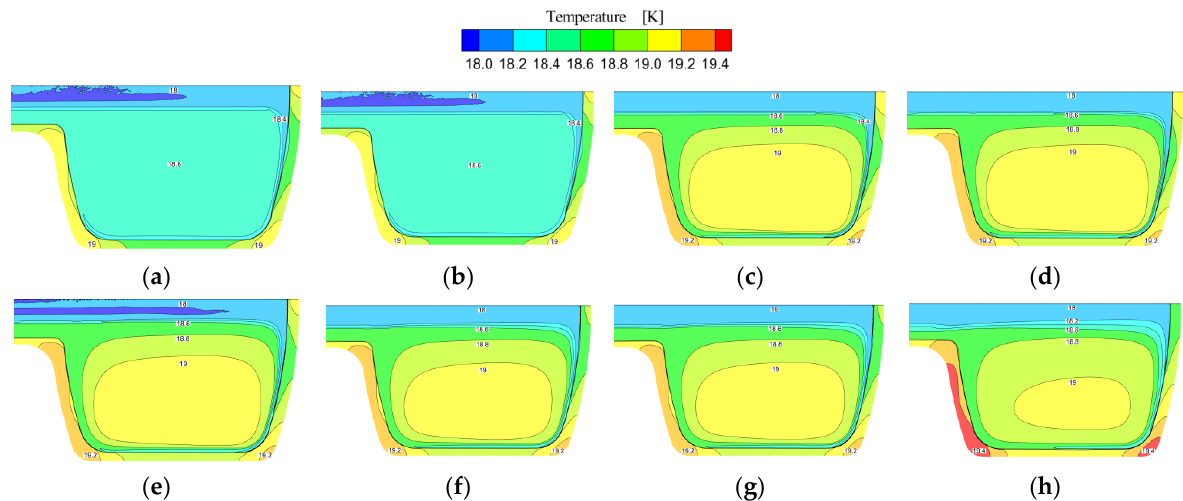
Figure 12. Temperature contour of moderator at proton beam power = 100 kW: ( a ) H/D = 0.5; ( b ) H/D = 1; ( c ) H/D = 1.5; ( d ) H/D = 3; ( e ) H/D = 4.5; ( f ) H/D = 5; ( g ) H/D = 5.5; ( h ) H/D = 6.